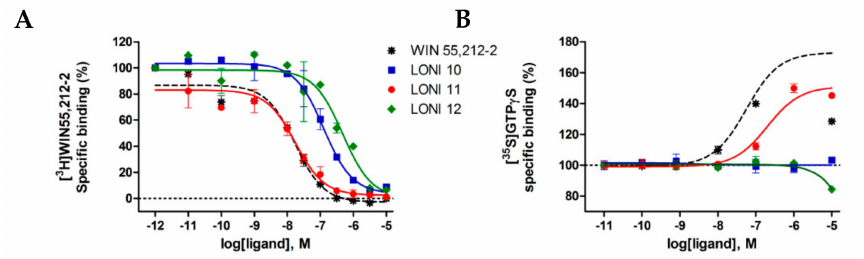
Figure 2. ( A ) CBs receptor binding a ffi nity of LONI 10-12 in [ 3 H]WIN55,212-2 competition binding assays to rat whole brain membrane homogenates. Figures represent the specific binding of the radioligand in percentage in the presence of increasing concentrations (10 − 10 –10 − 5 M) of the indicated ligands. Data are expressed as percentage of mean specific binding ± S.E.M. ( n ≥ 3). ( B ) G protein activation e ff ects of the novel ligands in [ 35 S]GTP γ S binding assays in rat brain membrane